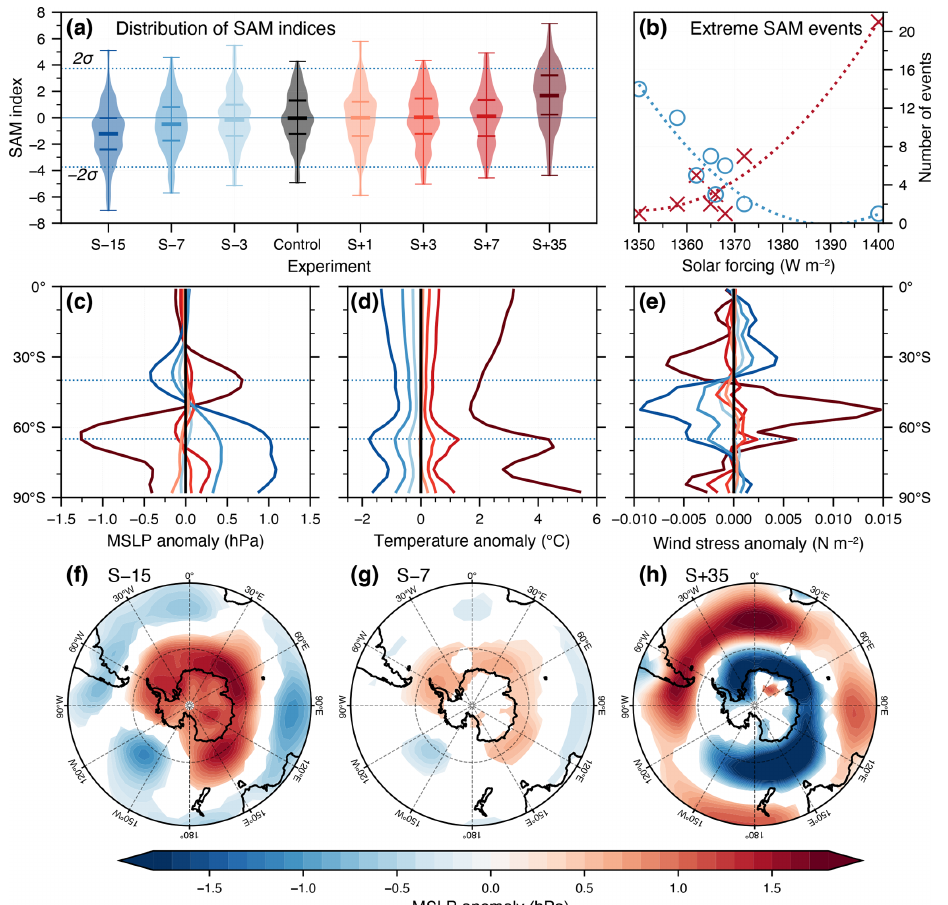
Figure 5. SAM index and events for the first 200 years of fixed solar-forced model runs. (a) Violin plots of the distribution of mean annual SAM index calculated for each solar constant run. Coloured horizontal lines refer to the 25th percentile, mean, and 75th percentile. (b) Number of extreme SAM events (outside ± 2 σ of the control run) in 200 years, with a second-order line of best fit for positive and negative events. Blue circles refer to extreme negative SAM events, and red crosses refer to extreme positive SAM events. (c–e) Zonal mean anomalies for the first 200 years of the experiments for (c) mean sea level pressure, (d) surface air temperature, and (e) surface zonal wind stress (positive values indicate westerly anomalies), where the anomaly is relative to the control run. Colours for each experiment correspond to those used in panel (a) . Dashed lines at 40 and 65 ◦ S are the latitudes used to calculate the SAM index. (f–h) MSLP anomalies relative to the control for the first 200 years in the (f) S − 15, (g) S − 7, and (h) S + 35 experiments. Regions shown are significantly different to the control run (based on Welch’s t test, P < 0 . 05); areas where P ≥ 0 . 05 have been masked